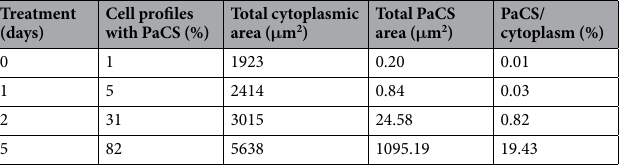
Table 1. PaCS development during GM-CSF + IL4 induced DC differentiation from human blood monocytes. Data from a representative experiment on 100 randomly selected TEM cellular profiles for each treatment